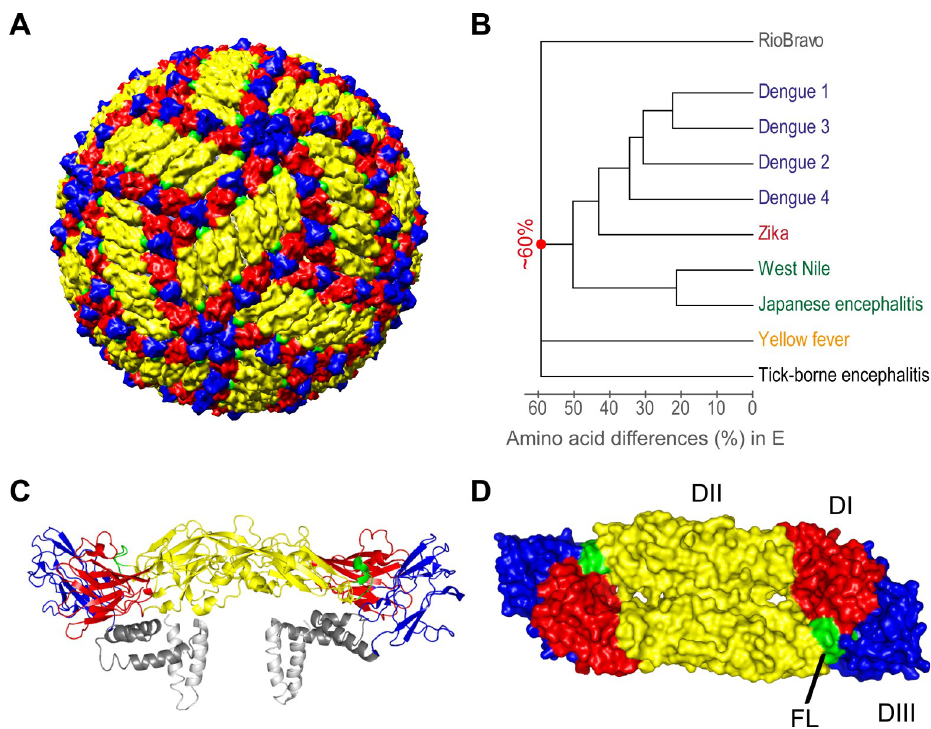
Fig 1. Structure of Zika virus and antigenic relationships of flaviviruses. (A) Zika virus particle (PDB: 6CO8, [22]). (B) Distance relationships between flavivirus E proteins based on amino acid sequence differences. (C) Ribbon diagram of the Zika virus E dimer (side view) and (D) surface representation of the Zika virus E dimer (top view). Color code: domain I (DI), red; domain II (DII), yellow; domain III (DIII), blue; stem and transmembrane domains, gray; fusion loop (FL), green. Figures were prepared with Pymol (Schro¨dinger LLC, www.pymol.org) and Chimera (http://www.rbvi.ucsf.edu/chimera, [23]). Sequences of E were obtained from the ViPR data bank (https://www. viprbrc.org). GenBank accession numbers are as follows: U27495 for tick-borne encephalitis virus, AY640589 for yellow fever virus, DQ211652for West Nile virus, D90194 for Japanese encephalitis virus, KJ776791 for Zika virus, AF226687 for dengue 1 virus, DQ863638 for dengue 3 virus, M29095 for dengue 2 virus, GQ398256 for dengue 4 virus, and NC_003675 for Rio Bravo